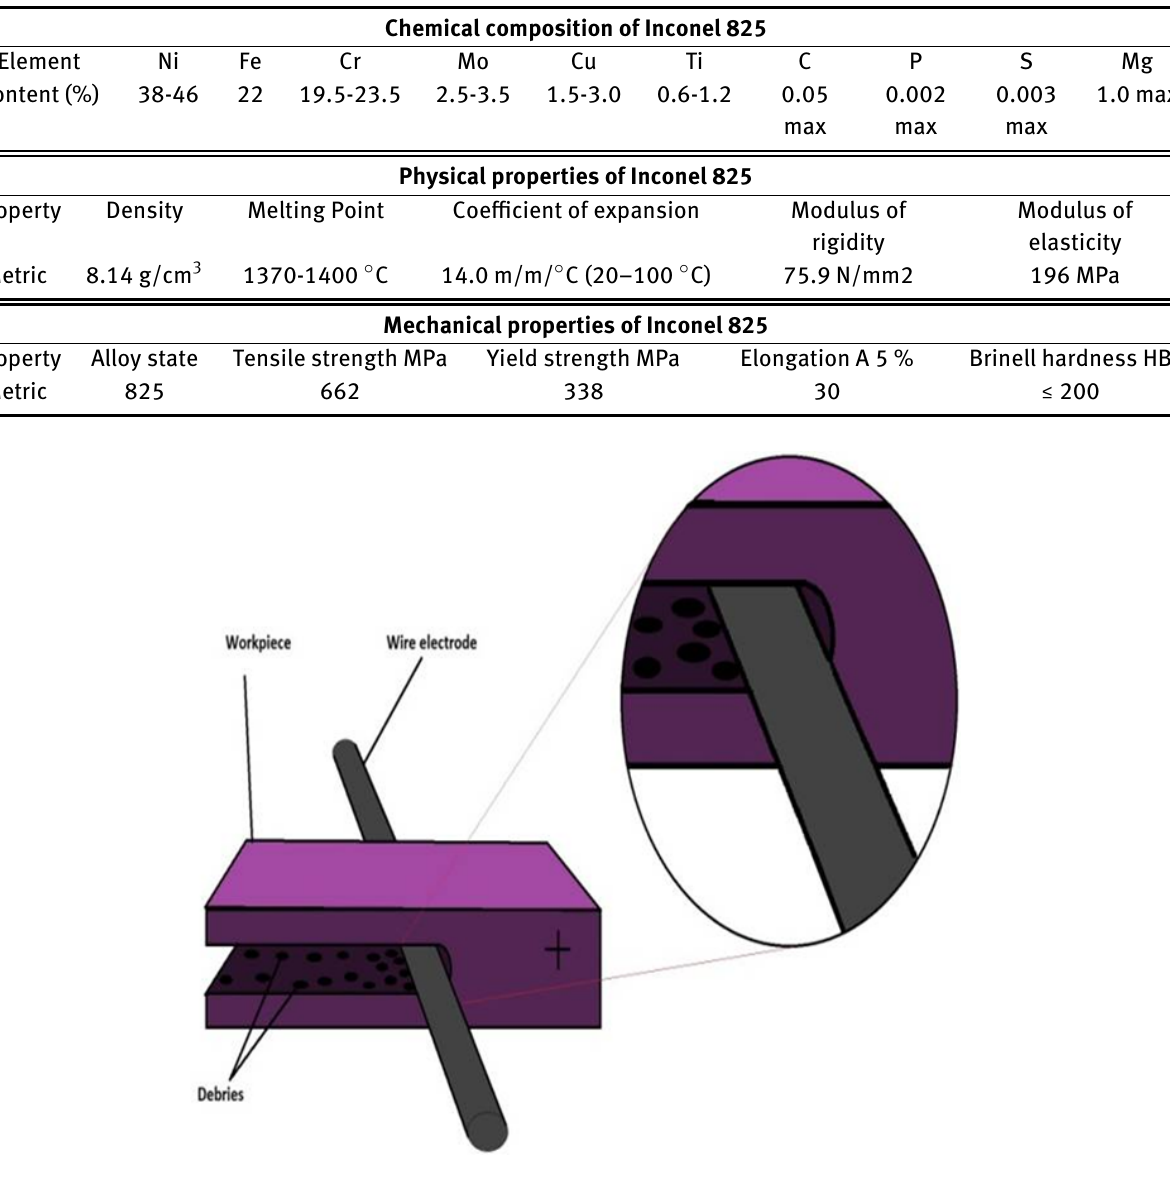
Table 1: Chemical, physical and mechanical properties of Inconel 825